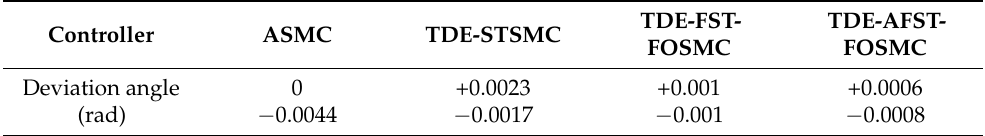
Figure 7. Front wheel deviation under shock disturbance. Table 4. Deviation of the front wheels under shock